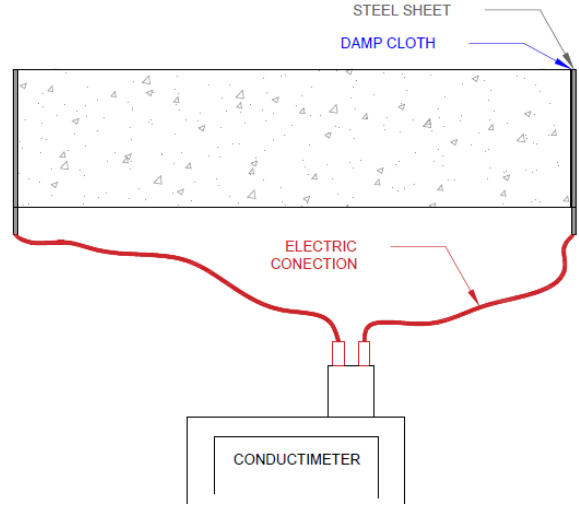
Figure 3. Assembly for measuring with a conductimeter.